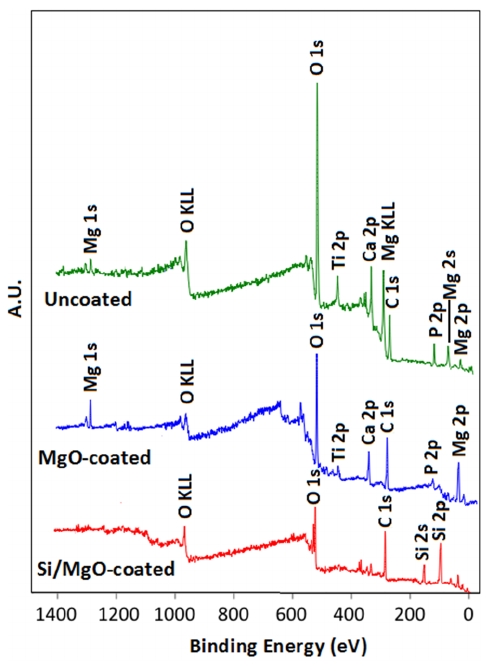
Figure 3. Survey X ‐ ray photoelectron spectroscopy (XPS) spectra of the uncoated, MgO ‐ coated and Figure 3. Survey X-ray photoelectron spectroscopy (XPS) spectra of the uncoated, MgO-coated and Si/MgO ‐ coated after the milling ‐ pressing ‐ sintering process. Si/MgO-coated after the milling-pressing-sintering